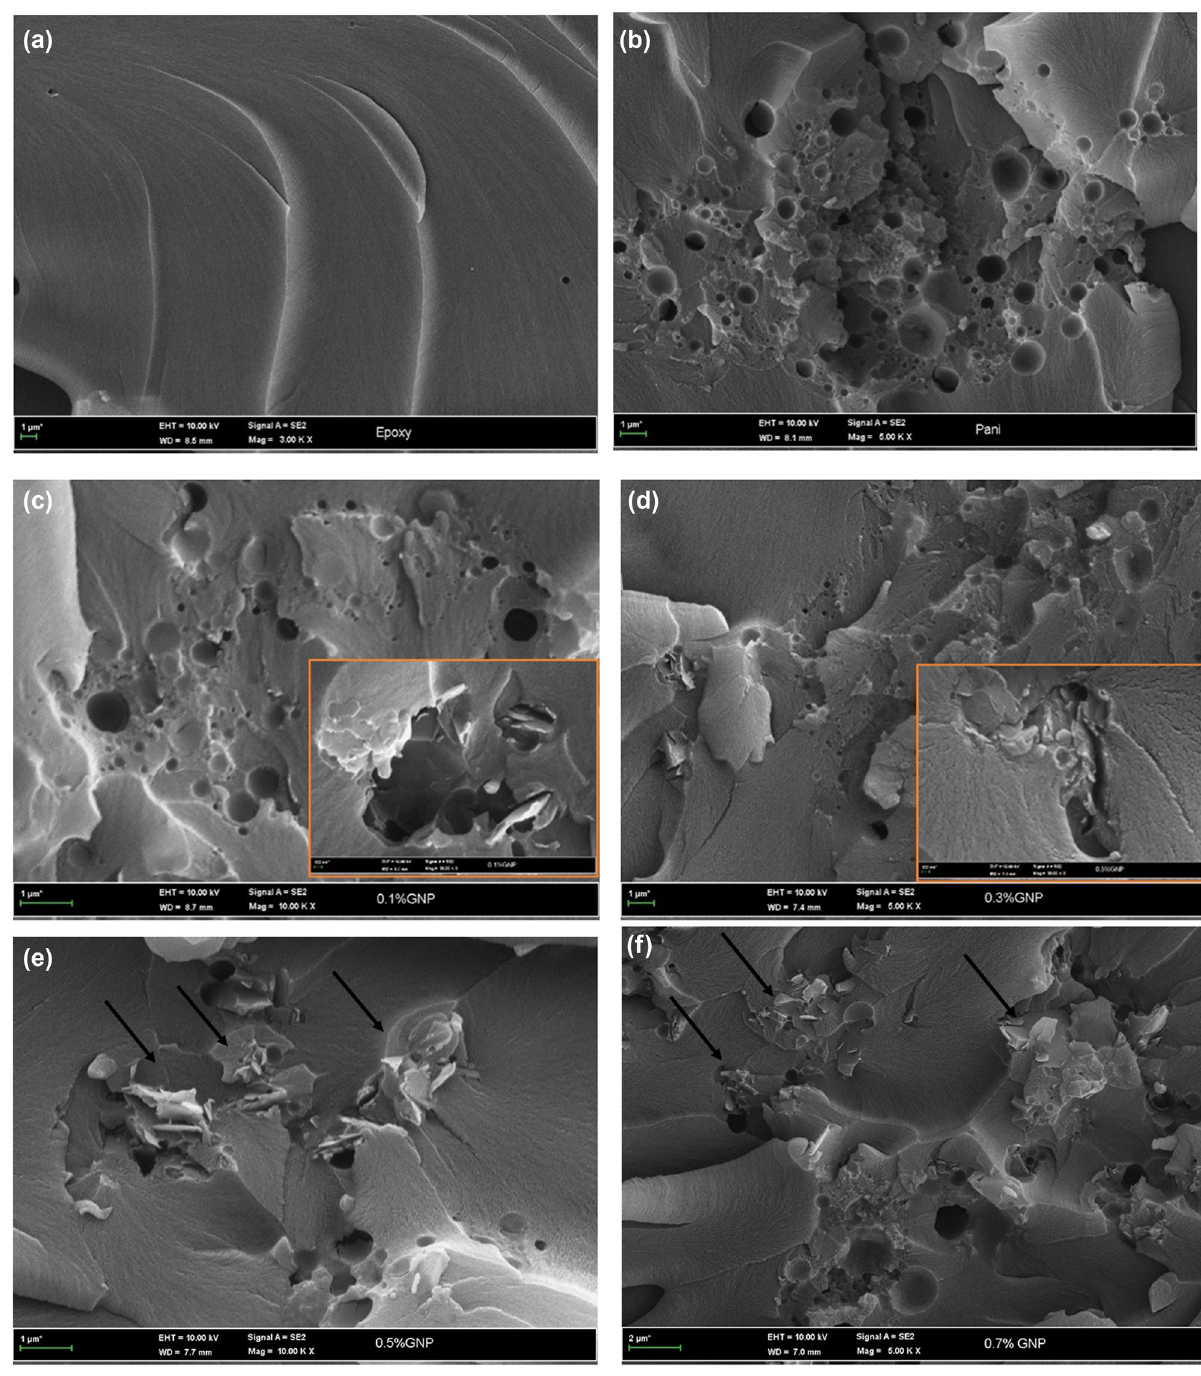
Figure 8: FESEM micrographs of ( a ) epoxy, ( b ) epoxy/PANI, ( c ) NC1, ( d ) NC2, ( e ) NC3, and ( f )